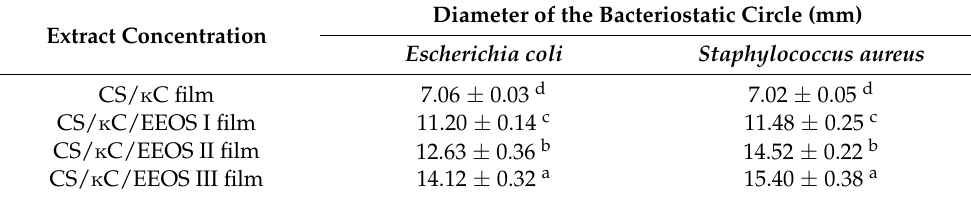
Table 2. Diameter of bacteriostasis circles of CS/ κ C and CS/ κ C/EEOS composite films against Escherichia coli and Staphylococcus aureus